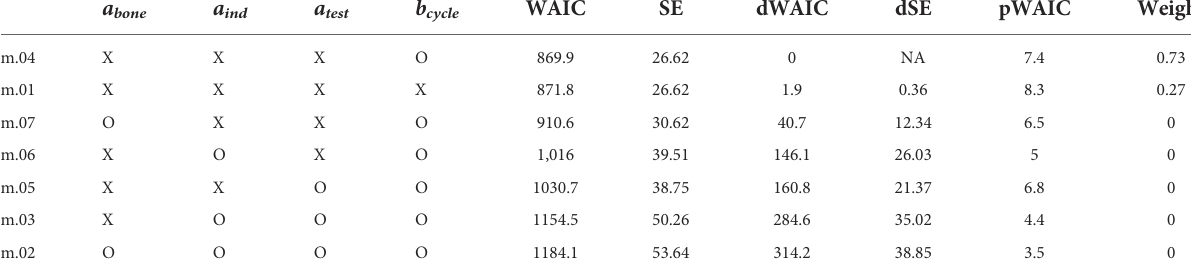
TABLE 4 WAIC results.